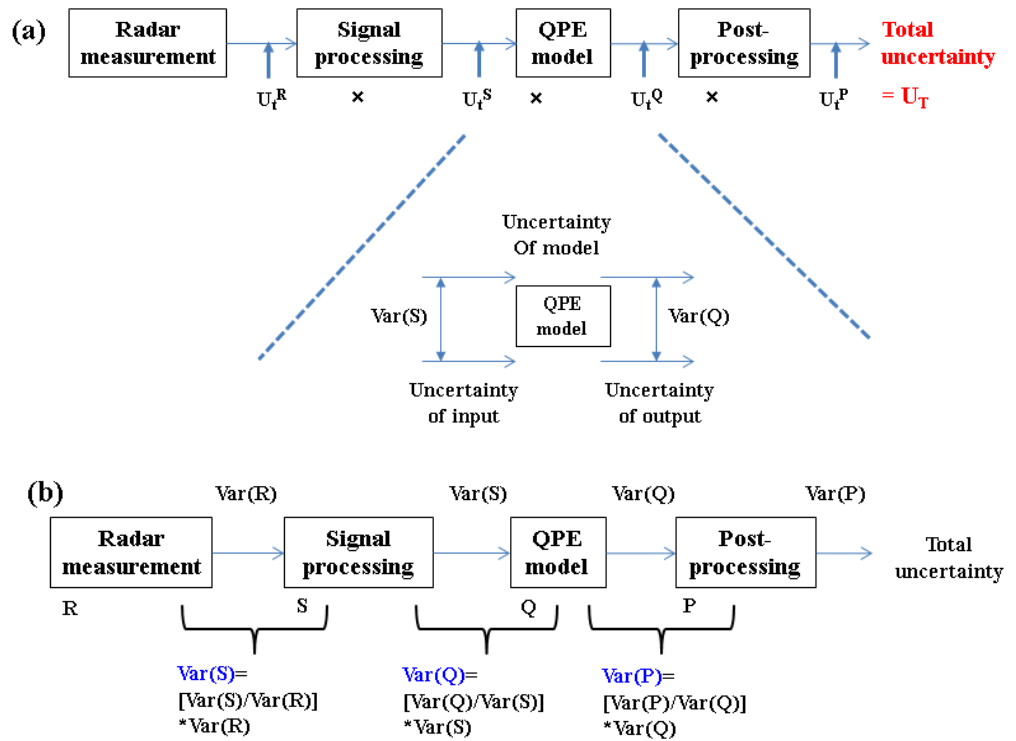
Figure 2. Basic concept of uncertainty Delta method (UDM): ( a ) uncertainty quantification and propagation in the precipitation estimation process, ( b ) quantification in each stage. QPE: quantitative precipitation estimation.